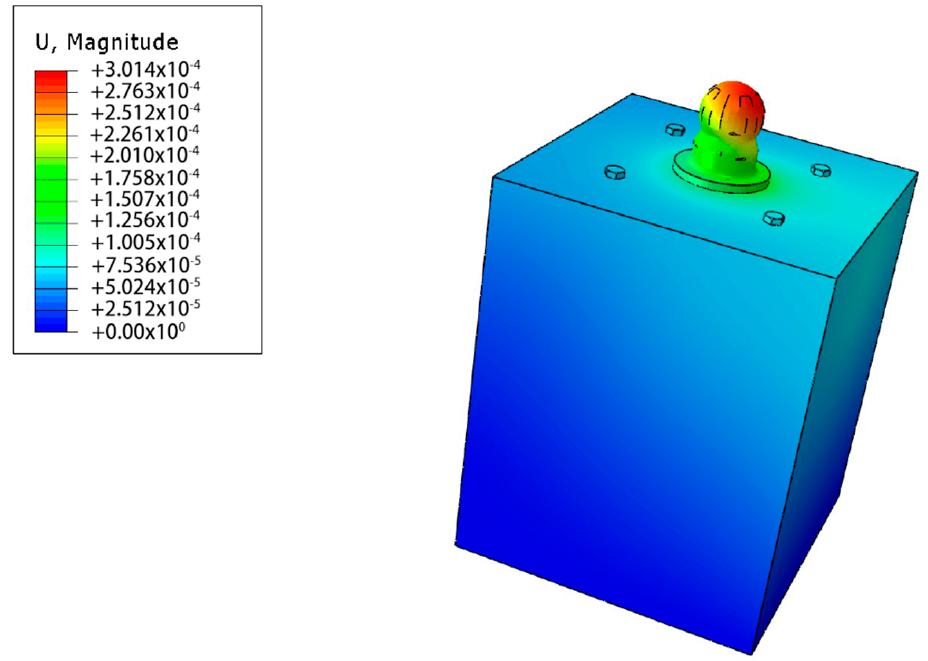
Figure 16. Resultant displacement distribution of the column support connection.